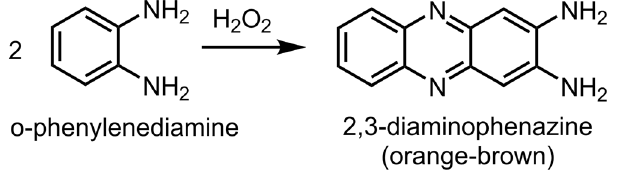
Figure 9. OPD reaction